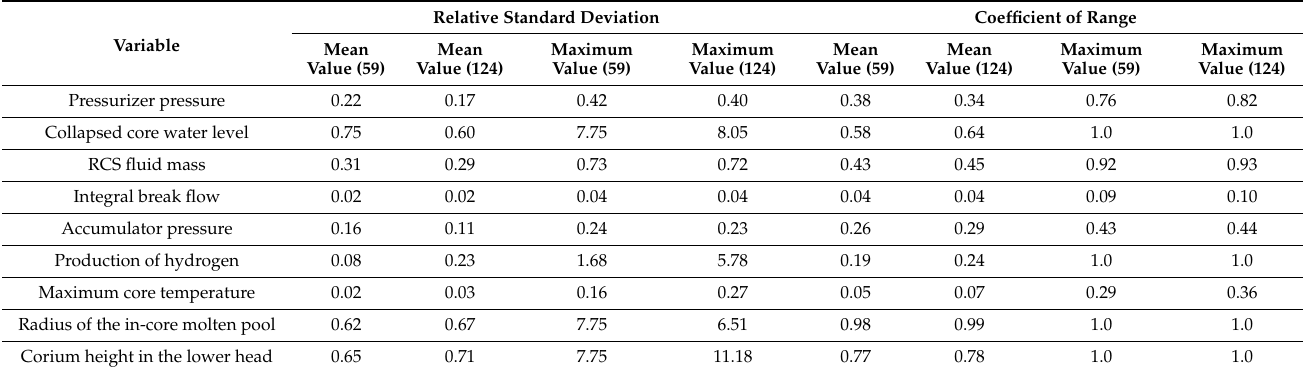
Table 2. Relative standard deviations and coefficients of range for output variables, mean and maximum